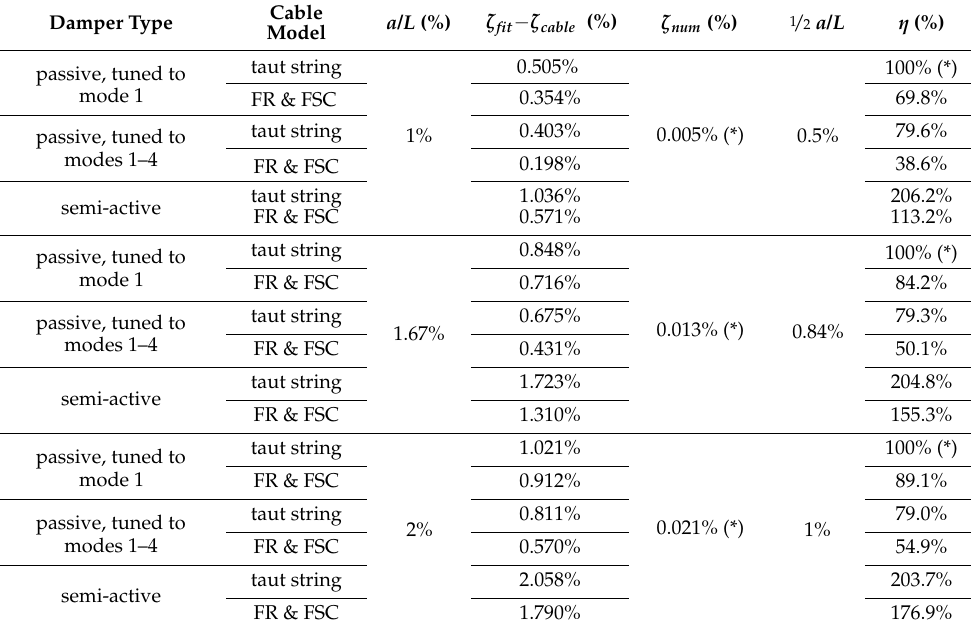
Table 1. Results for mode 1